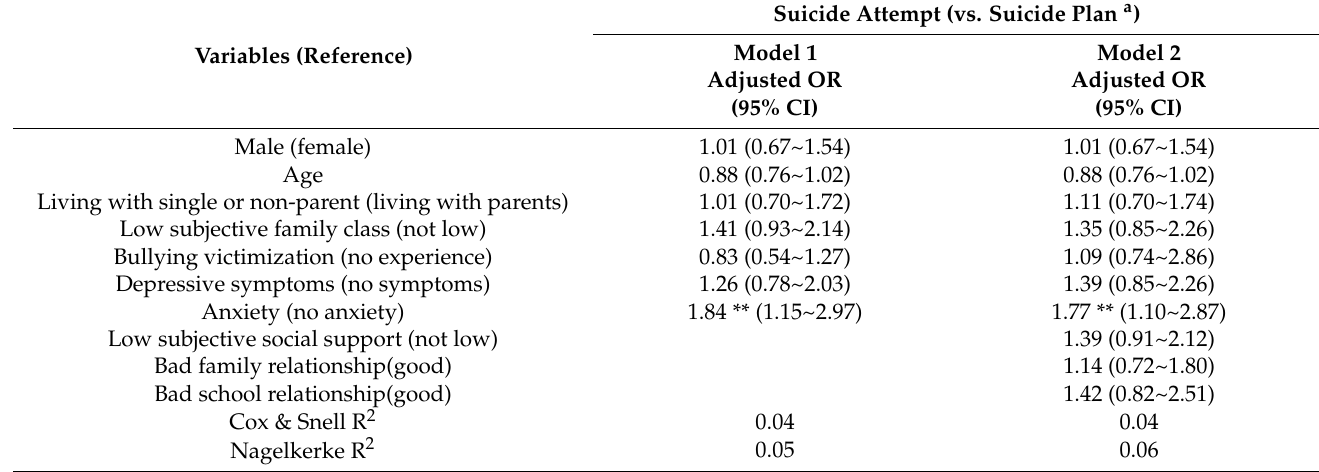
Table 4. Factors Associated with Suicide